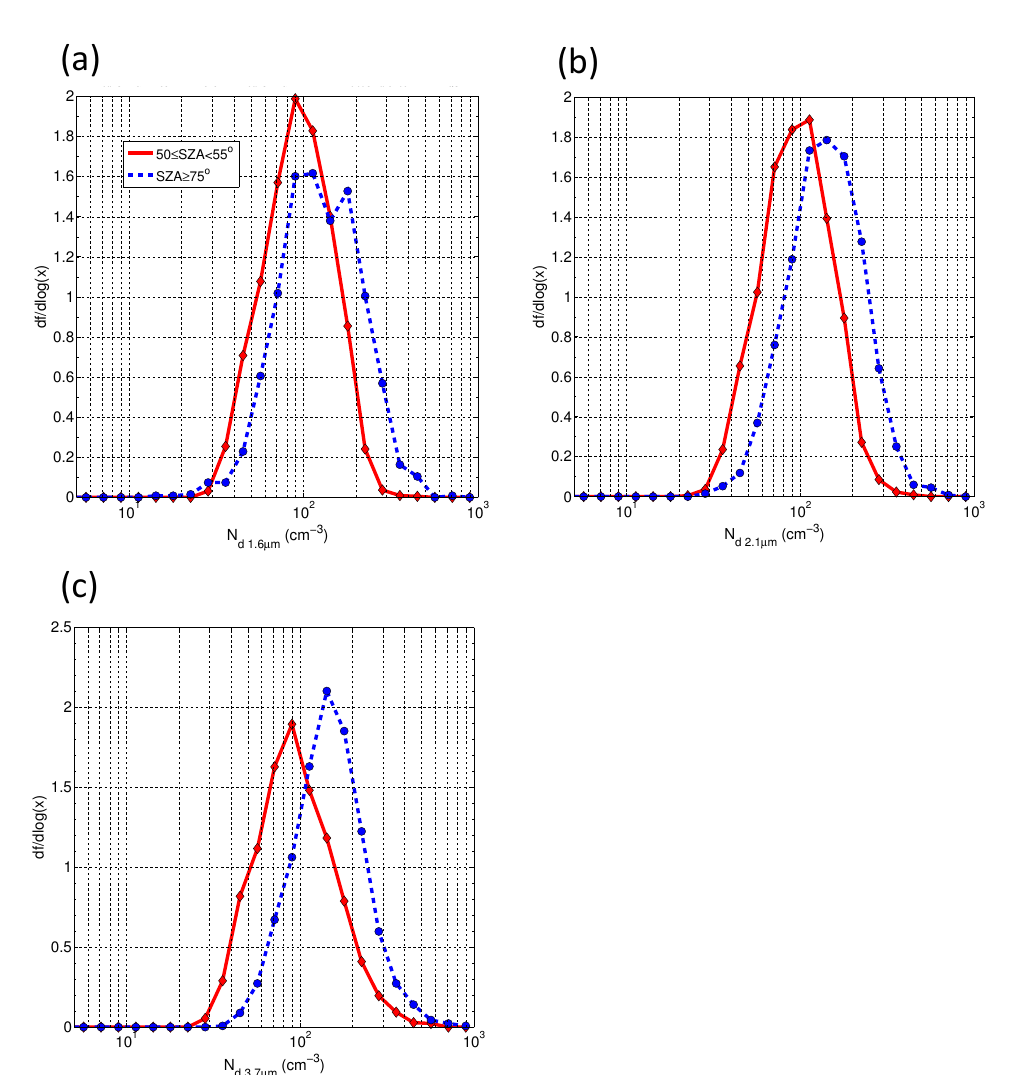
Figure 9. As for Fig. 8 except for N d except that probabilities are normalized by the bin widths in log 10